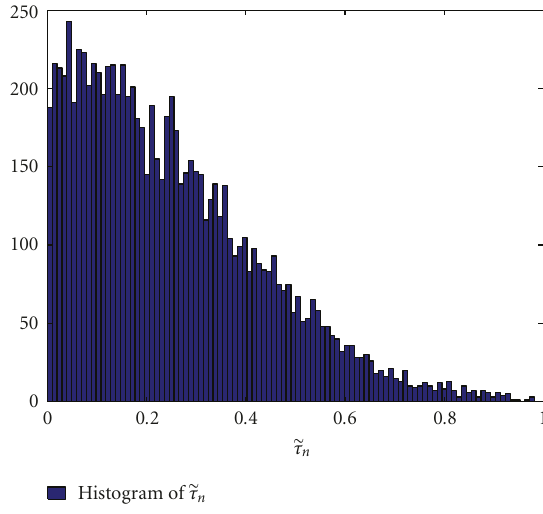
( (cid:9) τ n ) for v min = 2m / s. n